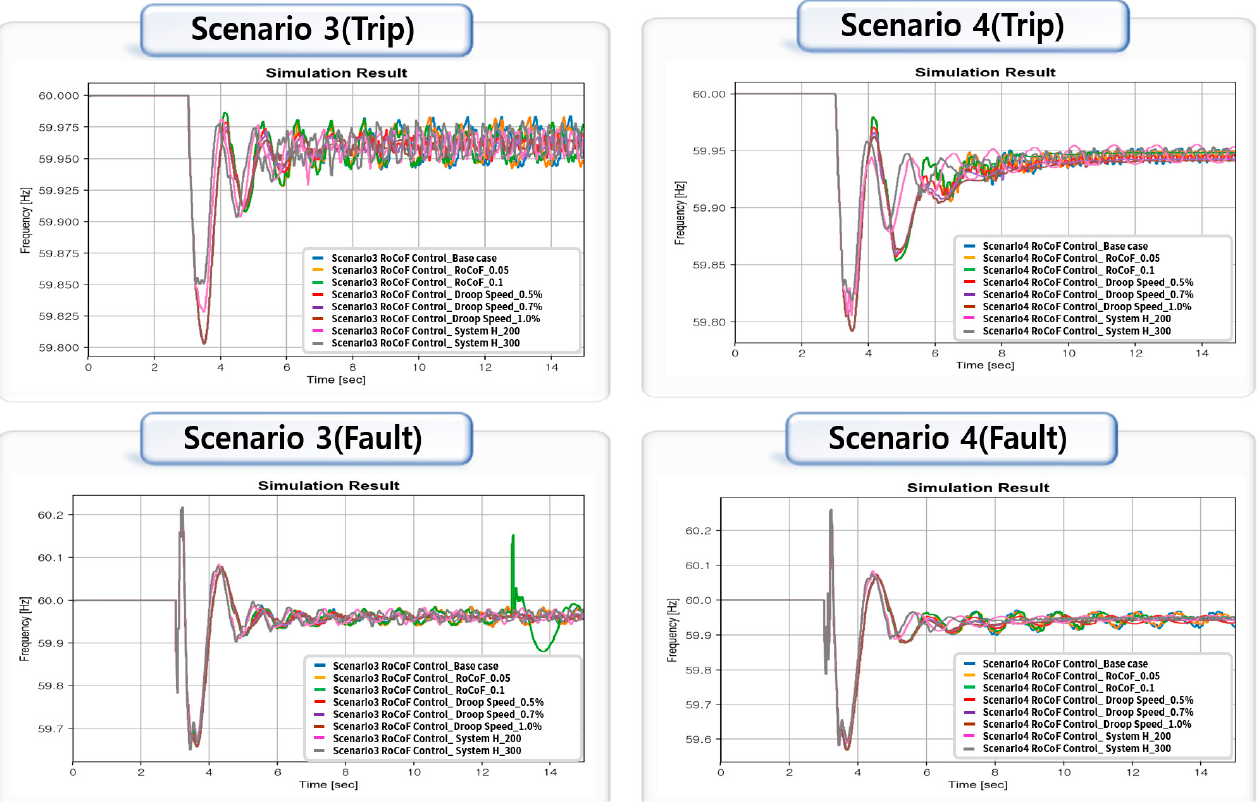
Figure 13. Frequency response by ESS parameter (RoCoF control).